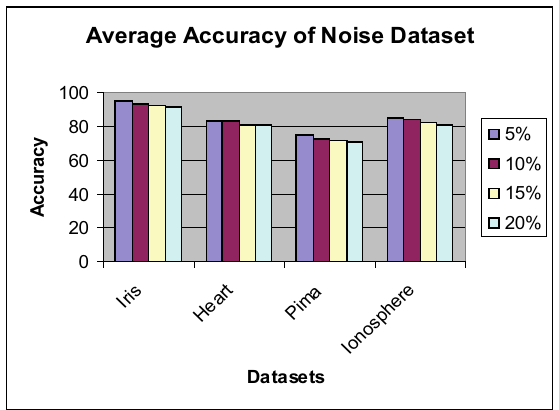
Figure 9: Classification Accuracy of DE-FLANN w.r.t Different Noisy